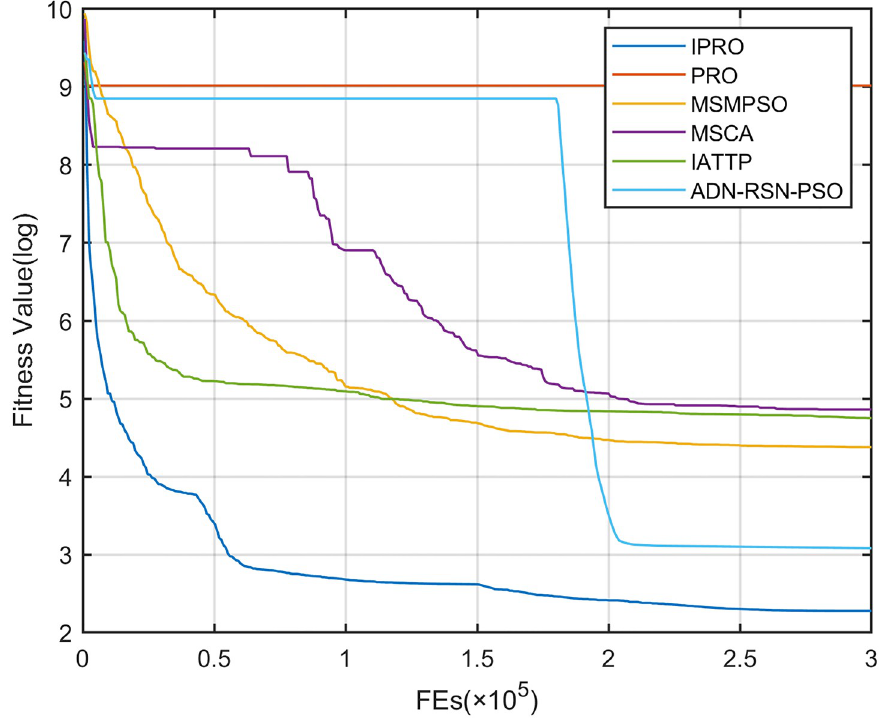
Fig 6. Convergence curves on